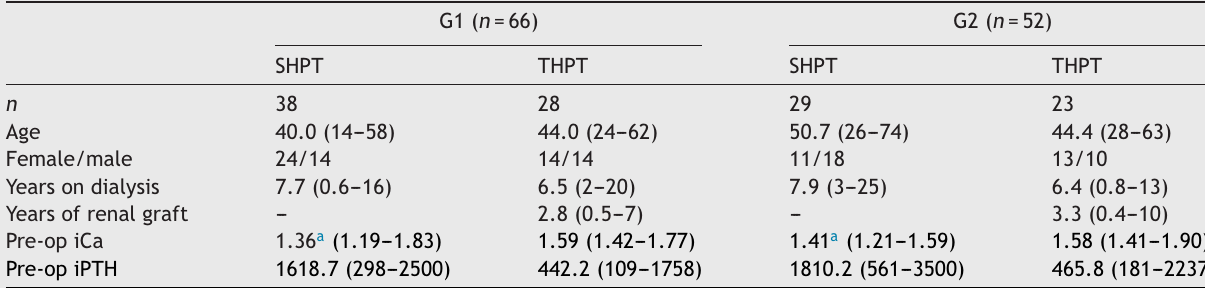
Pre-operative data and laboratory findings.